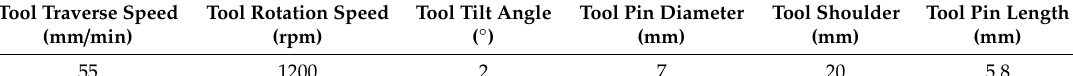
Table 2. Friction stir welding and submerged friction stir processing process parameters.